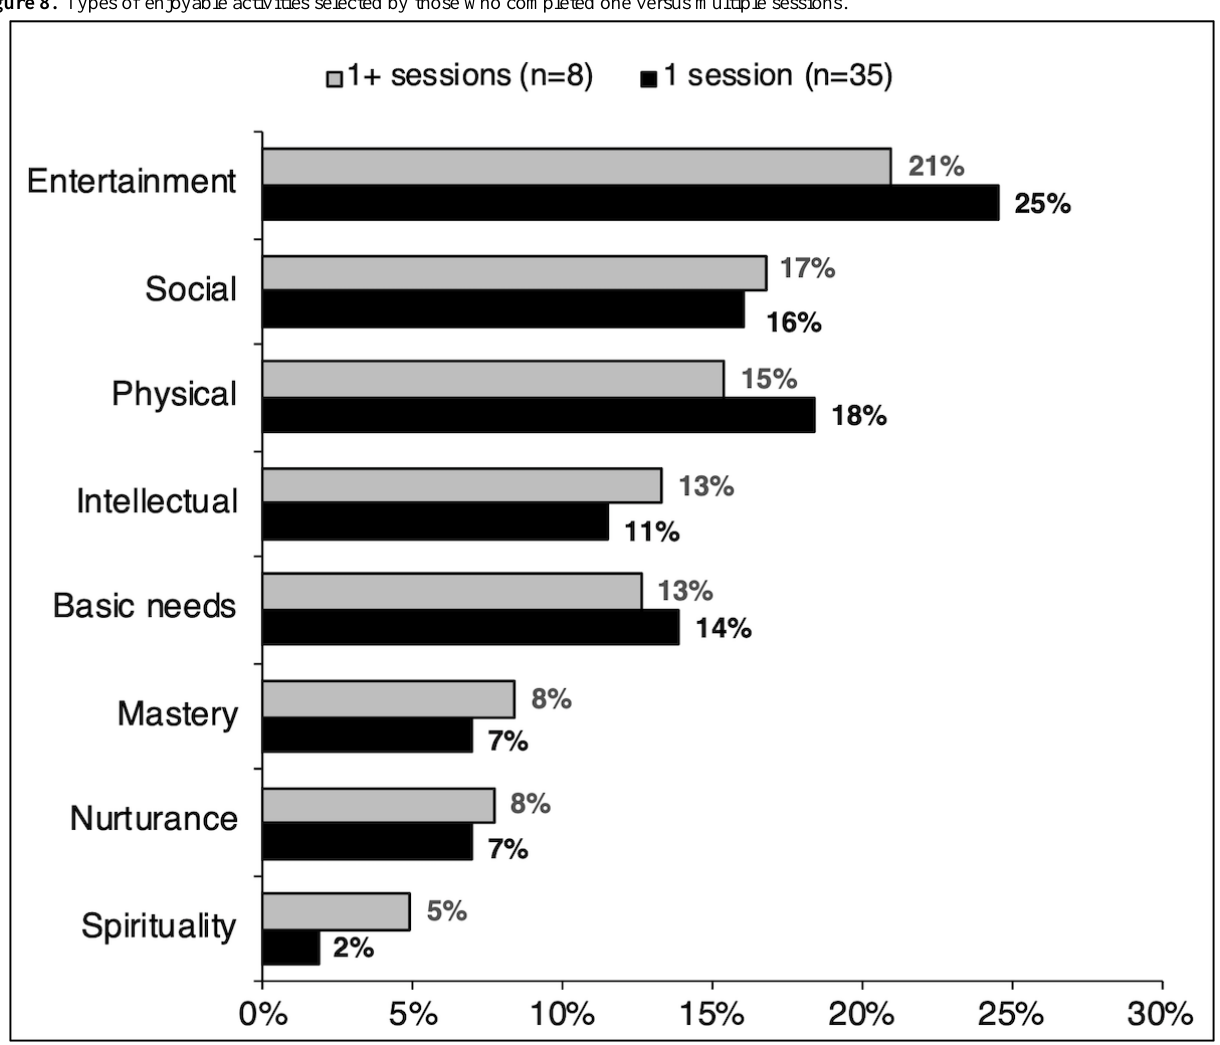
Figure 8. Types of enjoyable activities selected by those who completed one versus multiple